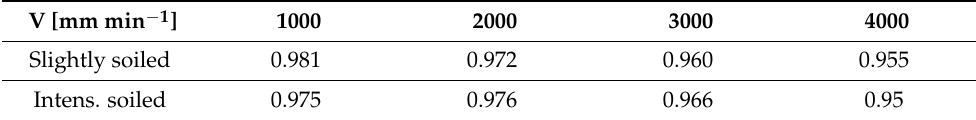
Table 7. Cleaning results for 60% power with a 1 mm gap.